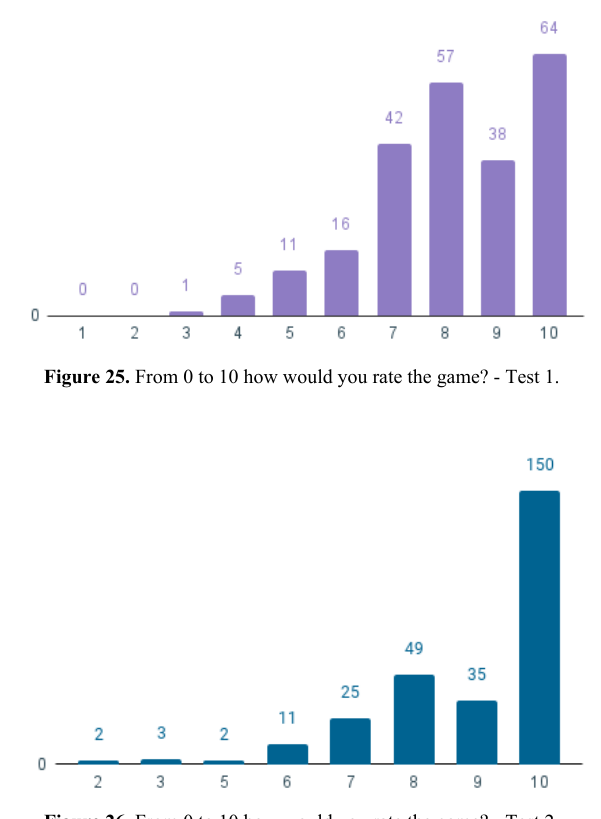
Figure 26. From 0 to 10 how would you rate the game? - Test